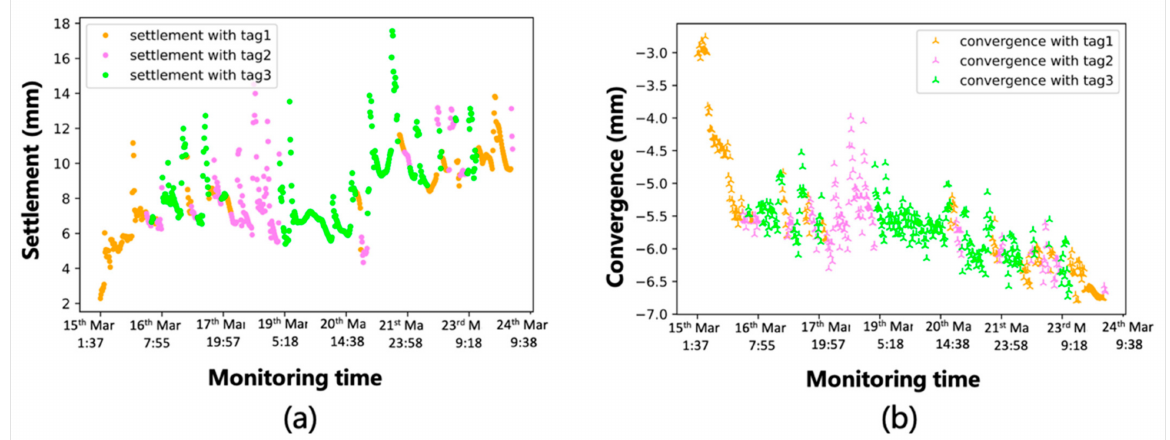
Figure 7. The positional tags of ( a ) the crown settlements and ( b ) the horizontal convergence values corresponding to different construction